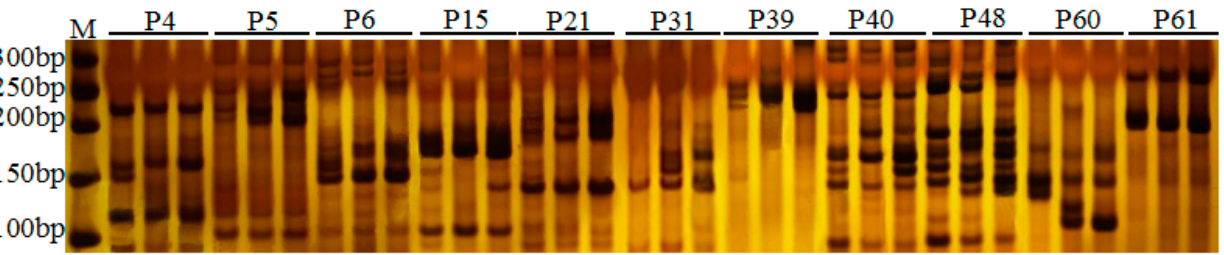
Figure 3. Amplified patterns of 11 pairs of polymorphic primers in ‘Ningzhi 4’ and its parents (‘Kiowa’ ( ♀ ) and ‘Hull Thornless’ ( ♂ )). P4, P5, P6, P15, P21, P31, P39, P40, P48, P60 and P61 are 11 pairs of polymorphic primers, and the three channels are in the same group. The genomic DNA of the female parent ‘Kiowa’, male parent ‘Hull’ and ‘Ningzhi 4’ are amplified, respectively. M: 50 bp DNA ladder.